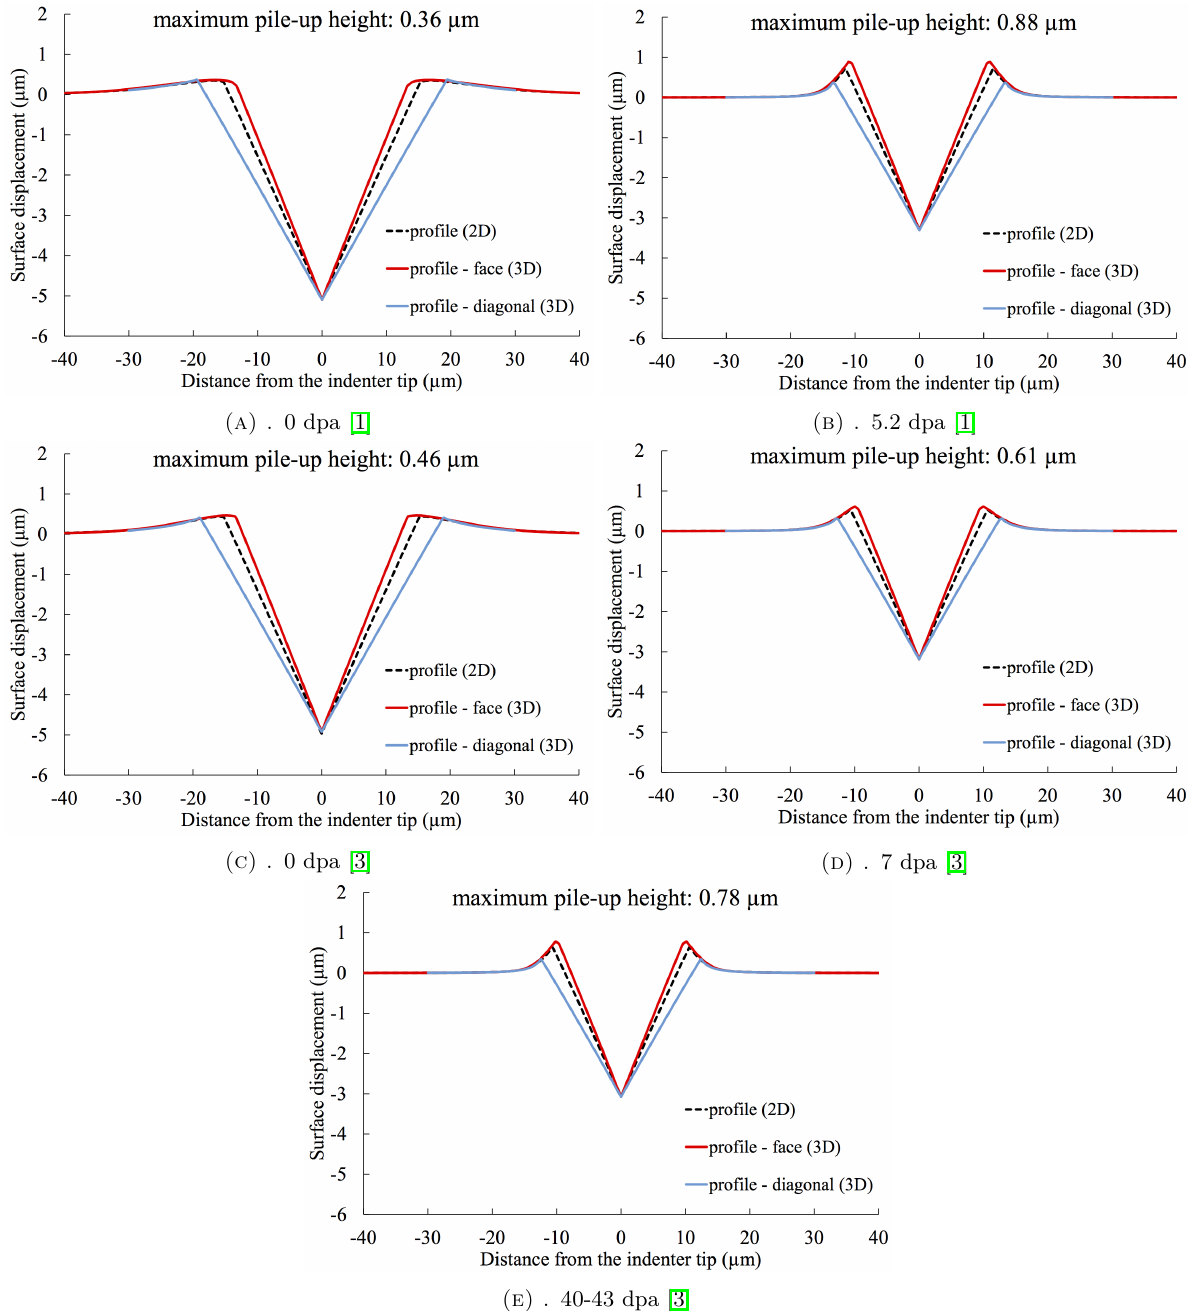
Figure 7. Computed surface displacement profiles; non-irradiated samples A and C, neutron irradiated samples B, D and E; , dataset [1] A and B, dataset [3] C, D and E; depicted surface area 40x40